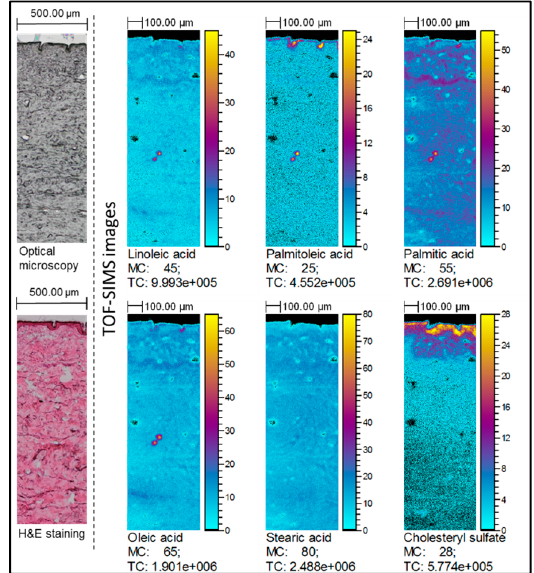
Figure 2. TOF-SIMS images of the skin treated with sea-buckthorn oil: spatial localization of selected ions compared to the optical image. TOF-SIMS images (negative ion mode) showing lateral distribution of palmitoleic, palmitic, linoleic, oleic and stearic acid ions in the skin. Field of view was 1.5 × 0.5 mm 2 , 750 × 250 pixels, pixel size 2 × 2 µ m 2 , fluence 5 × 10 11 ions/cm 2 . The amplitude of the color scale corresponds to the maximum number of counts MC and could be read as [0, MC]. TC is the total number of counts recorded for the specified m/z (the sum of counts in all pixels).